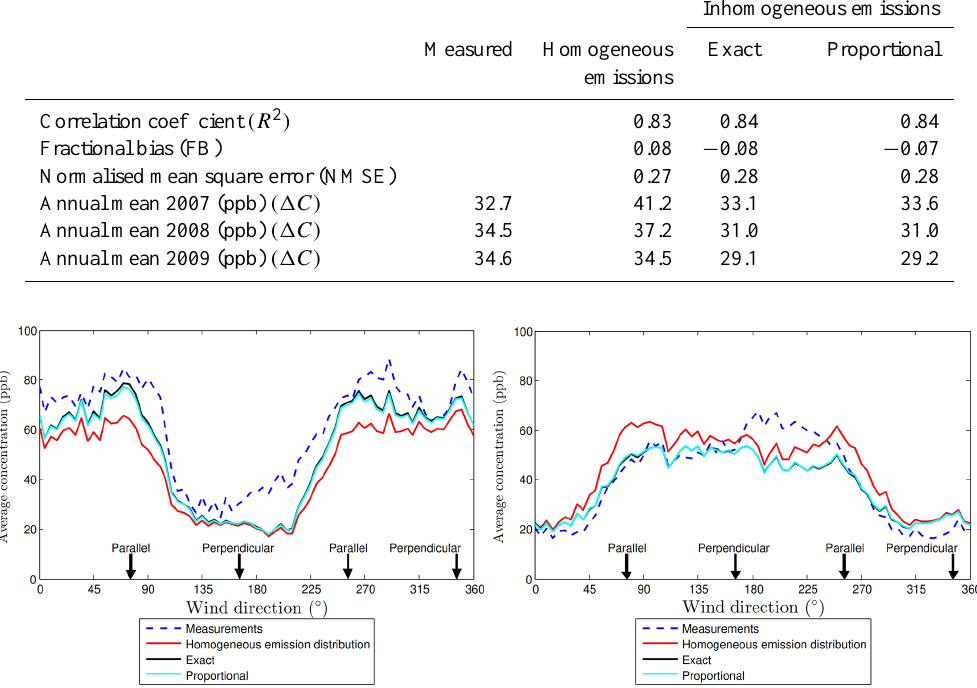
Figure 8. Mean NO x concentrations as a function of wind direction for the period 2007–2009 for the north side receptor (left side) and the south side receptor (right side). Where the black curve is hardly visible it is identical to the cyan curve.